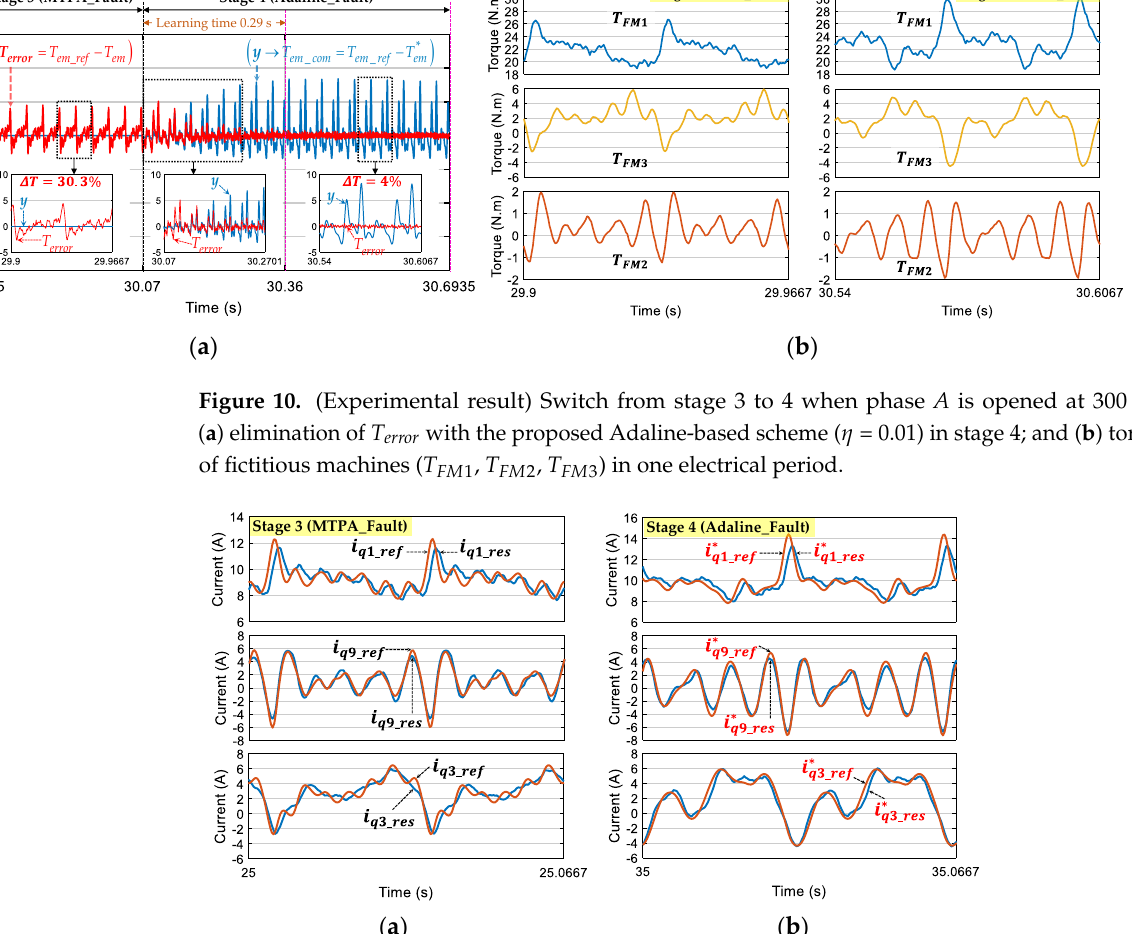
Figure 11. (Experimental result) The q-axis current control performance in one electrical period when phase A is opened at 300 rpm with: ( a ) conventional RFOC scheme using MTPA_Fault in stage 3; and ( b ) proposed scheme using Adaline_Fault ( η = 0.01) and ECL strategy in stage 4.